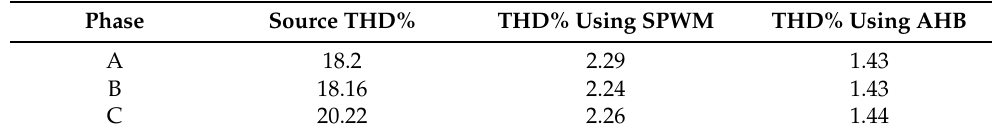
Figure 12. The simulation results of the current waveforms before and after compensation harmonics for the asymmetric load ( a ) load current, ( b ) UPQC current, and ( c ) source current. Table 7. The current THD for the case of asymmetric